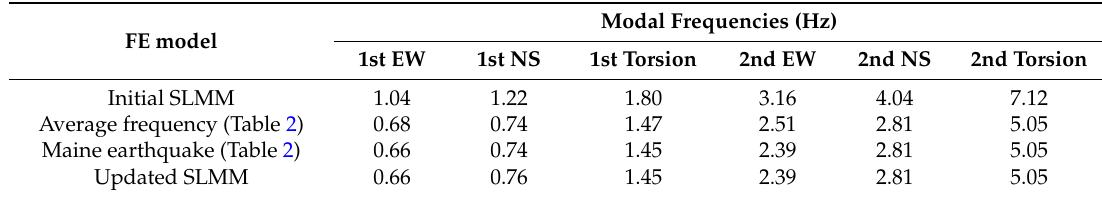
Table 7. Comparison between lumped-mass model modal frequency predictions with those determined using the Green Building accelerometer data.